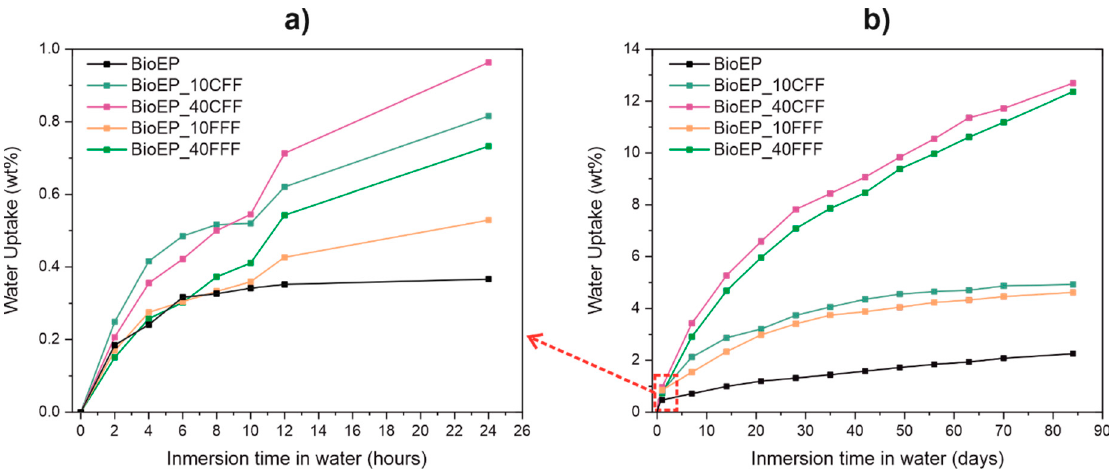
Figure 7. Evolution of water absorption over time of BioEP resin and BioEP composites filled with CFF (10 and 40 wt%) and FFF (10 and 40 wt%): ( a ) water absorption during the first 24 h; ( b ) water absorption during a period of 12 weeks. Table 4. Values of water saturation ( W s ), di ff usion coe ffi cient ( D ) and the corrected di ff usion coe ffi cient ( D c ) for BioEP resin and BioEP composites reinforced with di ff erent CFF and FFF